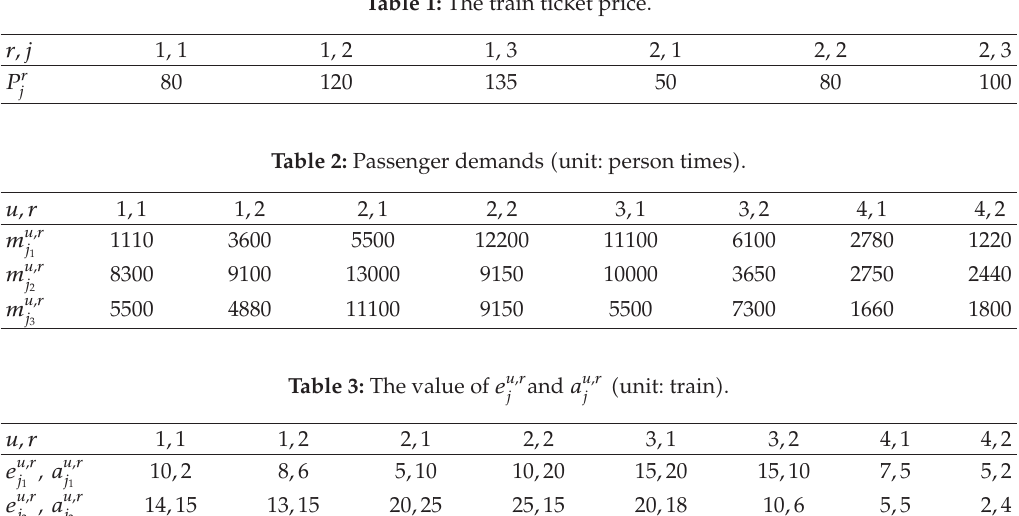
Table 1: The train ticket price.